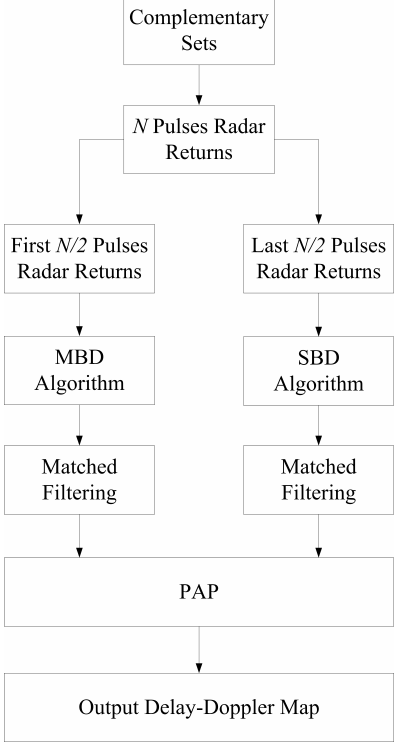
Figure 4. Float chart of the GBD procedure.